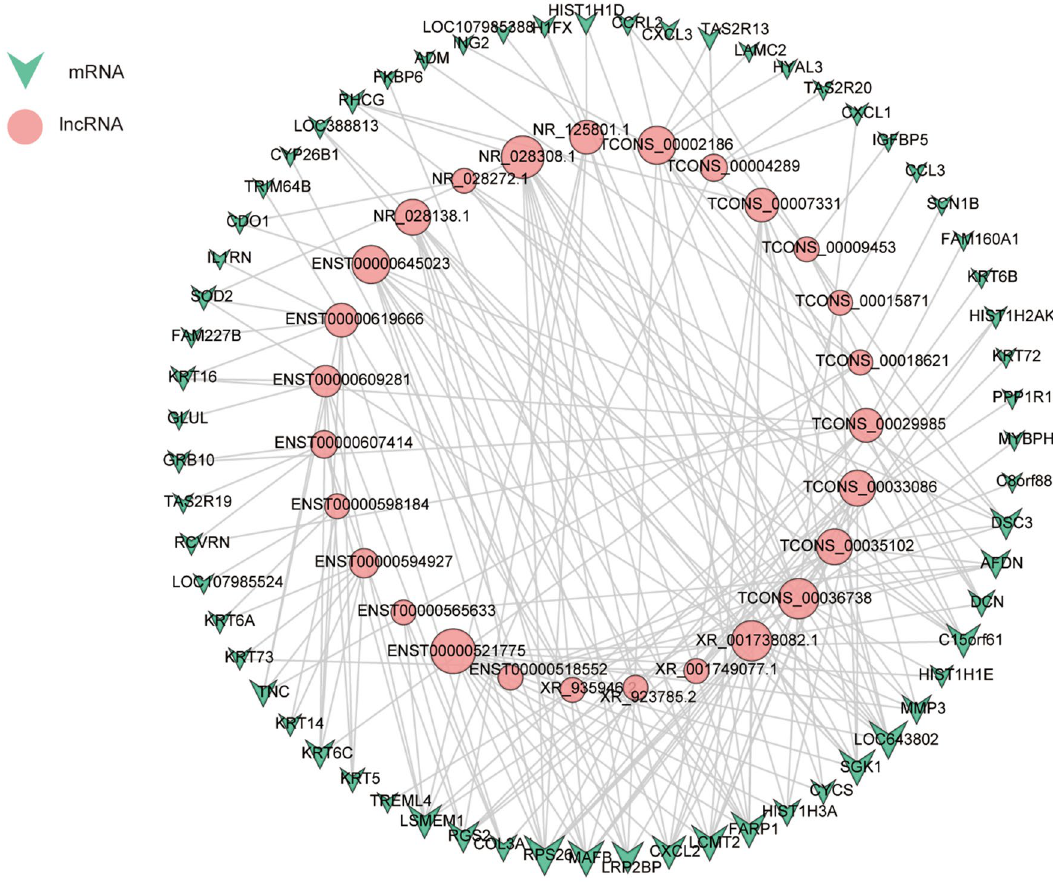
Figure 3. LncRNA-mRNA coexpression network. Pink circular nodes represent lncRNAs, and green triangles represent mRNAs. Gray lines correspond to coexpression relationships between lncRNAs and mRNAs (PCC >